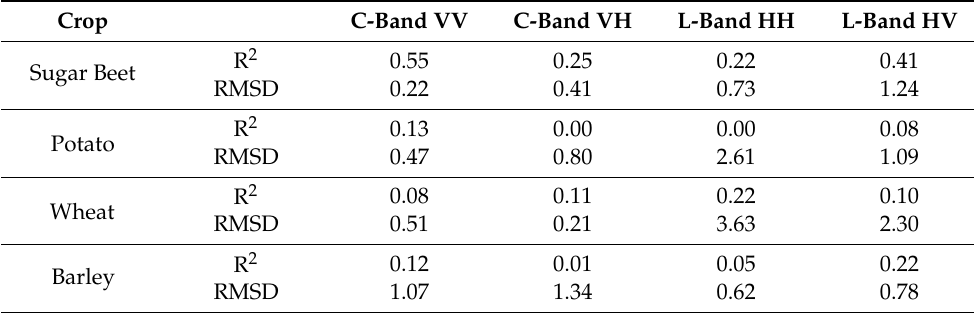
Table 6. R 2 and RMSD of the linear regression between backscattering signal and plant height.